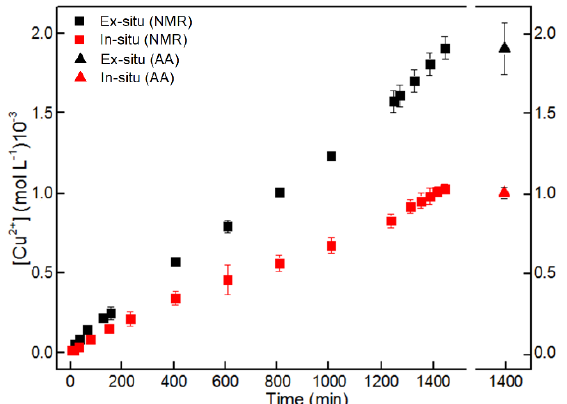
Figure 4. [Cu 2+ ] in the corrosive medium as function of reaction time. Black and Red squares are the [Cu 2+ ] determined by TD-NMR relaxometry, using Equation (4), for B = 0 and for B > 0, respectively. The data points represent the average of 3 measurements and the error bars represent the standard deviation. The black and red triangles are [Cu 2+ ] in solution for B = 0 and B > 0 at the end of the 24 h corrosion experiments, respectively, determined by